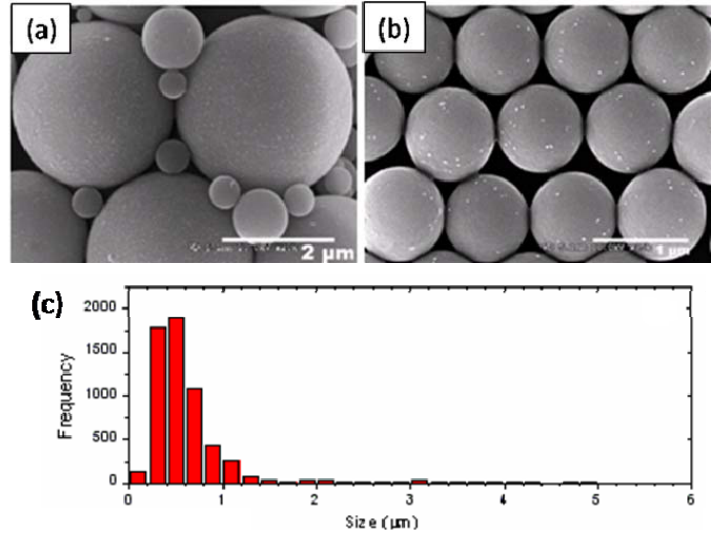
Figure 3. SEM images (a-b) and the size distribution (c) of polystyrene-silica particles prepared using KPS as the initiator.